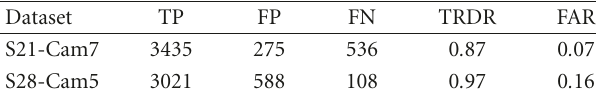
Table 4: Performance results of the local feature